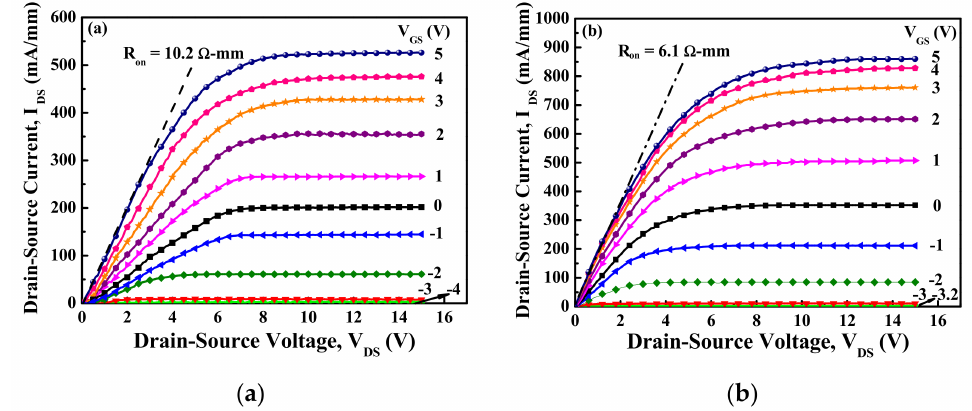
Figure 2. Typical drain–source current − drain–source voltage characteristics of double-channel MOSHEMTs with ( a ) planar channel and ( b ) multiple-mesa-fin-channel array